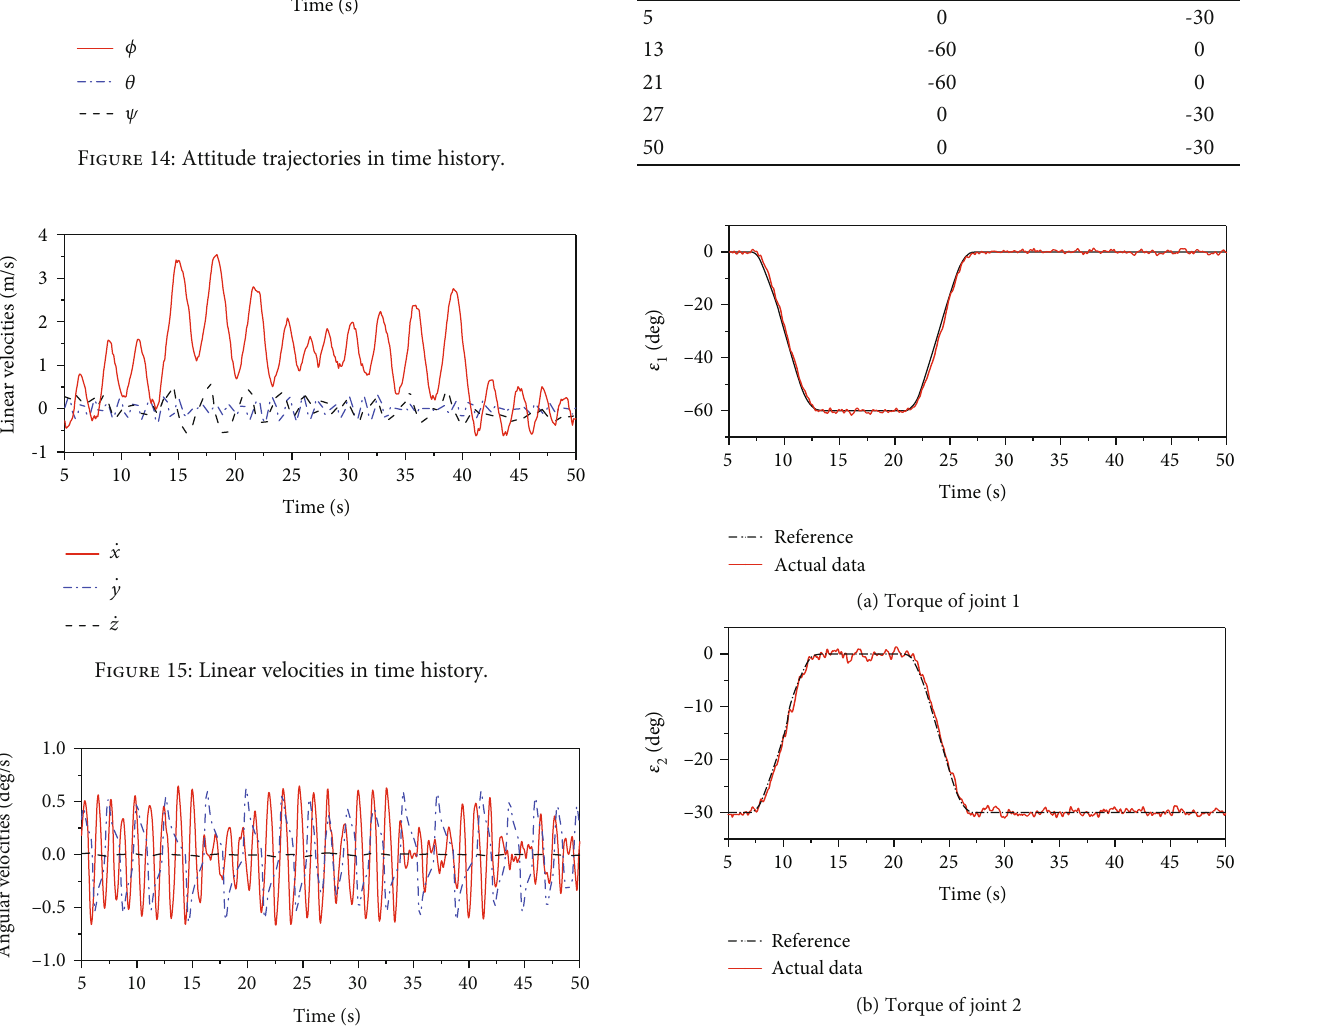
Figure 17: Joints of the manipulator in time